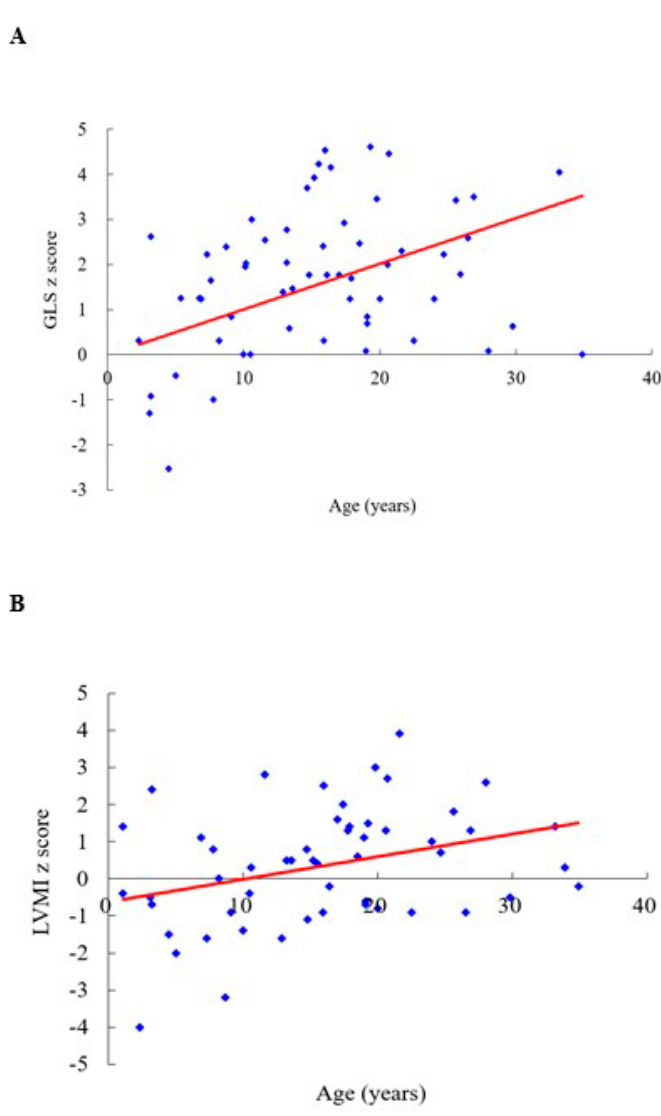
Figure 4. ( A ) The GLS z score is positively correlated with age (n = 53, r = 0.323, p < 0.05). ( B ) The LVMI z score is positively correlated with age (n = 53, r = 0.335, p < 0.05). GLS, global longitudinal strain; LVMI, left ventricular mass index. The red line represents the trendline. Table 4. Number and percentages of left ventricular remodeling patterns in various MPS types. Left Ventricular Concentric Eccentric Concentric Normal Remodeling Pattern Remodeling Hypertrophy